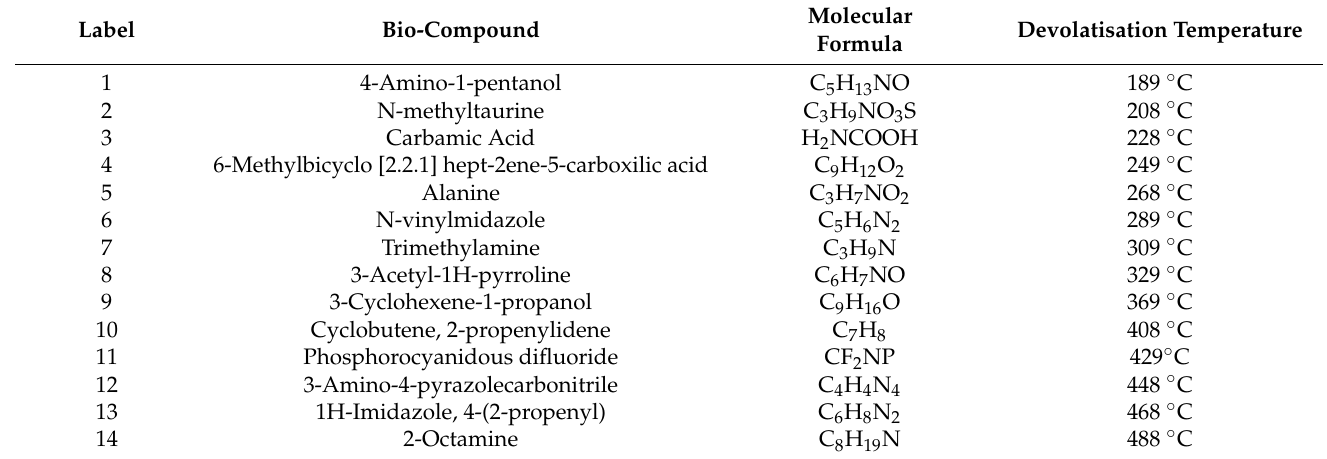
Table 3. Volatile compounds detected during the pyrolysis of the GC/MS analysis of endemic micro-algae consortium sample